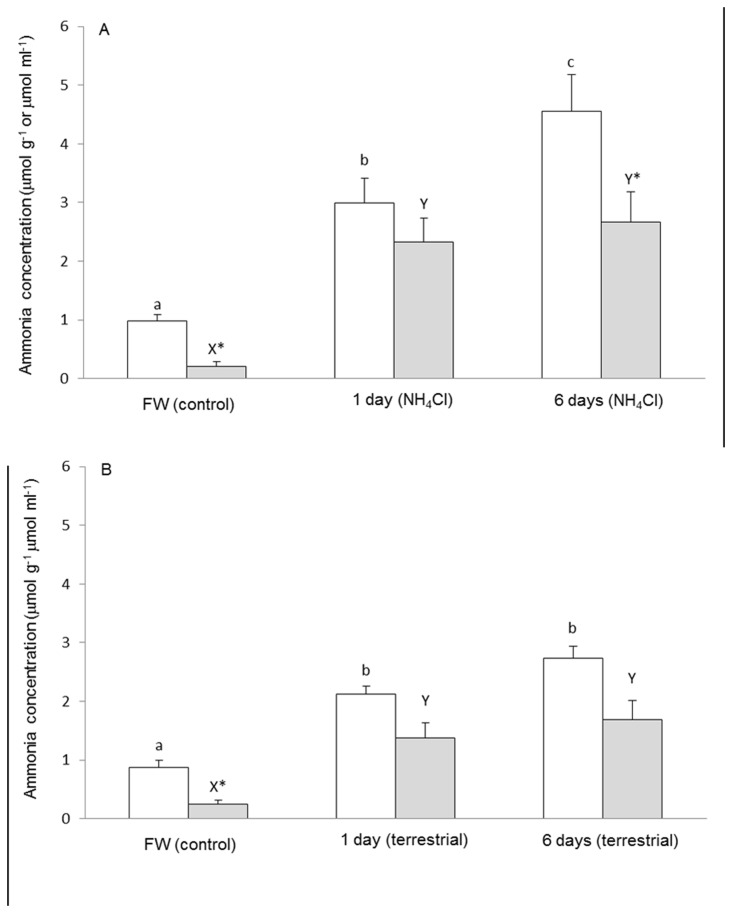
Concentrations of ammonia in the brain (µmol g-1; □) and plasma (µmol ml-1 or mmol l-1; ■) of

Monopterus

albus
.Fish were kept in freshwater (FW; control) or (A) exposed to 50 mmol l-1 NH4Cl (pH 7.0) or (B) terrestrial conditions for 1 day or 6 days. Results represent means ± S.E.M. (N=5). Means not sharing the same letter (a, b, c or x, y) are significantly different (P<0.05). *Significantly different from the value of the brain.